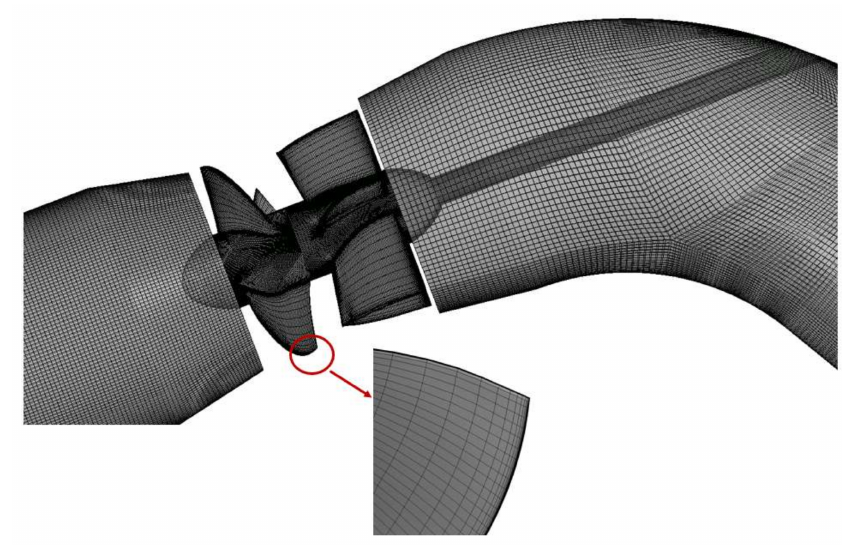
Figure 2. Axial-flow pump and impeller grid.